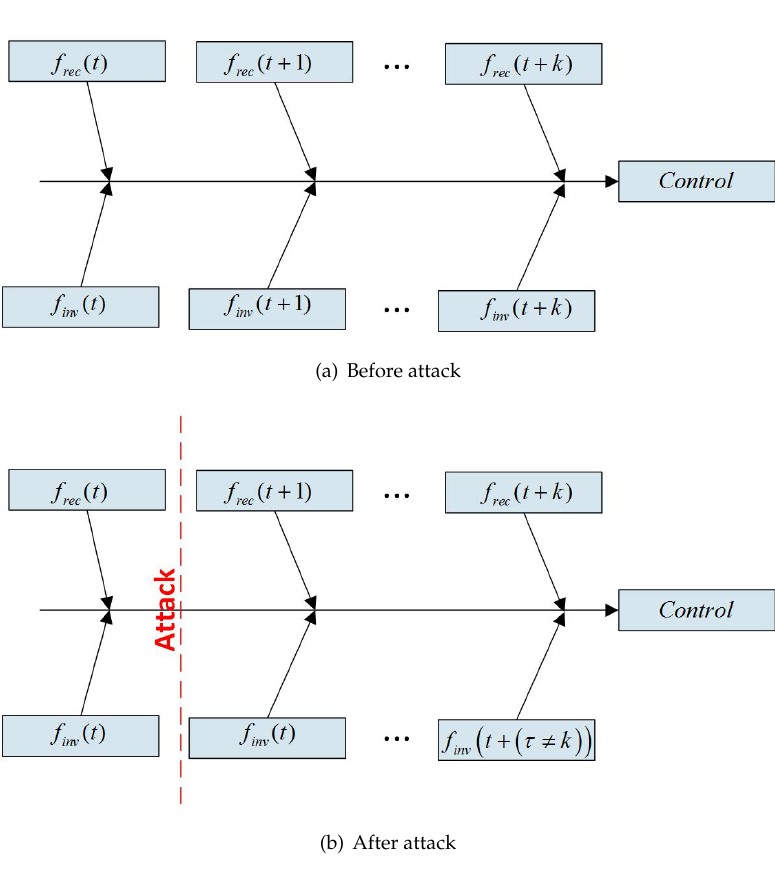
Figure 3. Principle of a timing attack on the HVDC damping